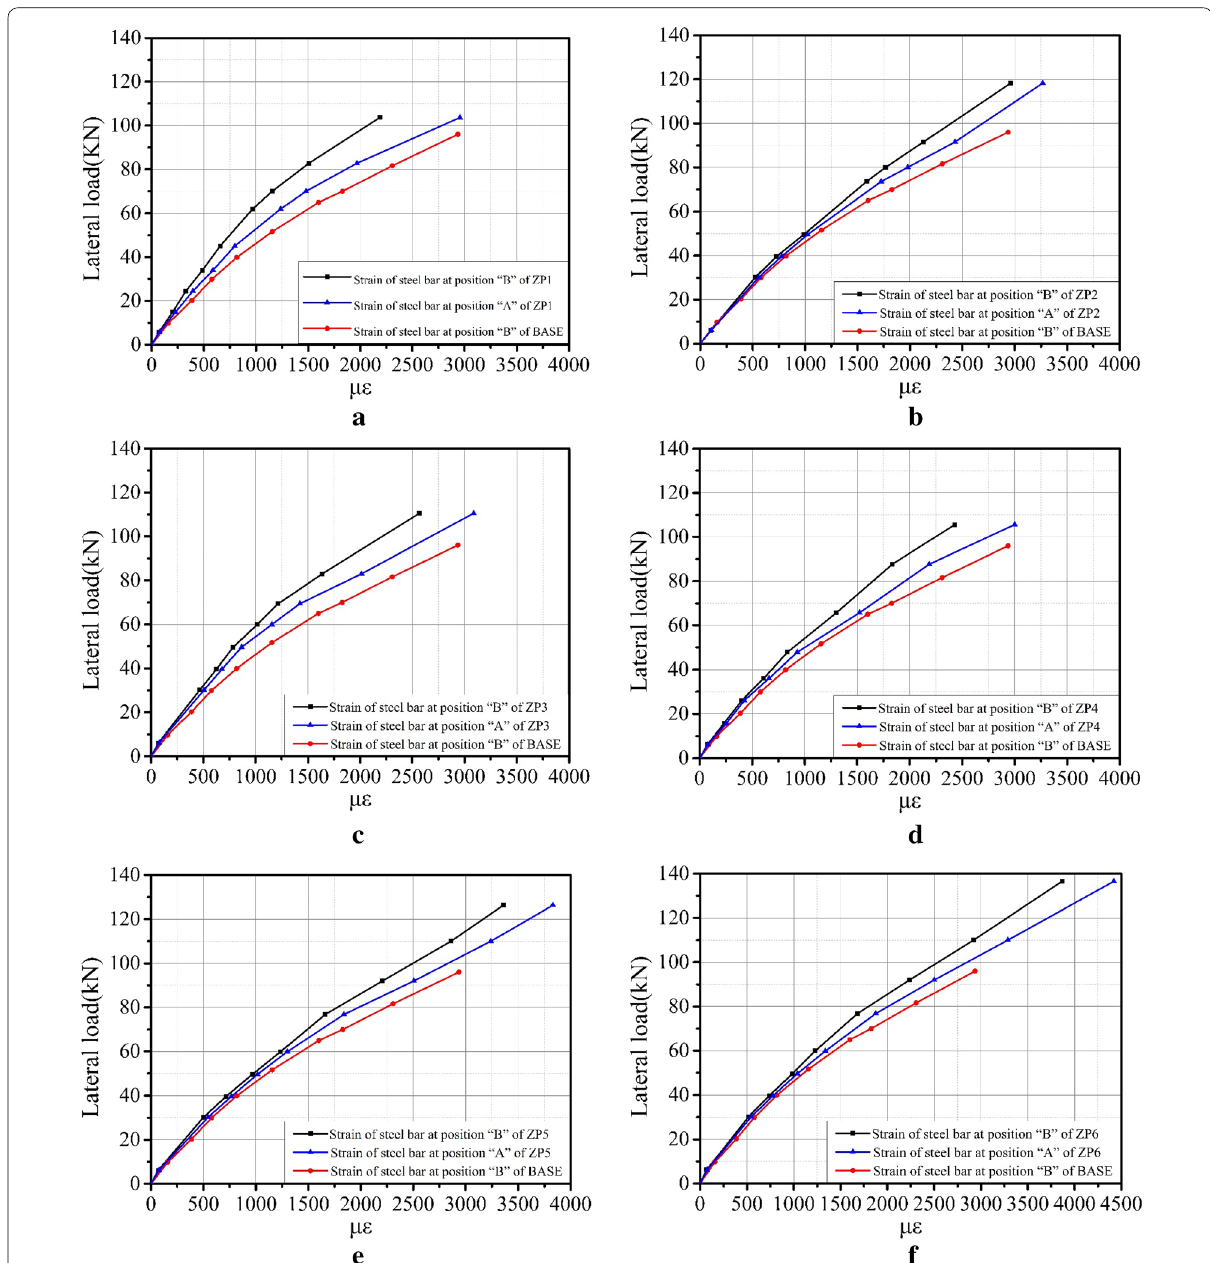
Fig. 9 Load–strain curves of reinforcing bars at the A and B positions of the specimens: a ZP1; b ZP2; c ZP3; d ZP5; e ZP4; f